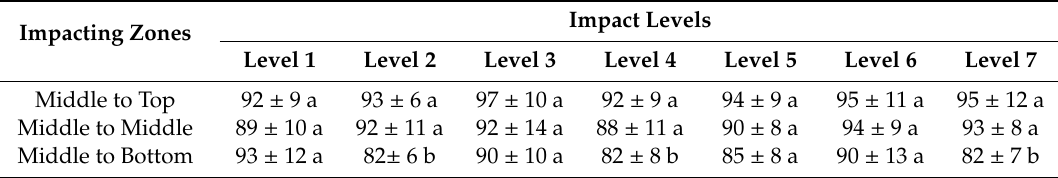
Table 1. Mean (± standard deviation) weights (g) of 21 groups of moving fruits used to impact stationary fruits at 21 different locations in three different test zones on fruit surfaces [i] .